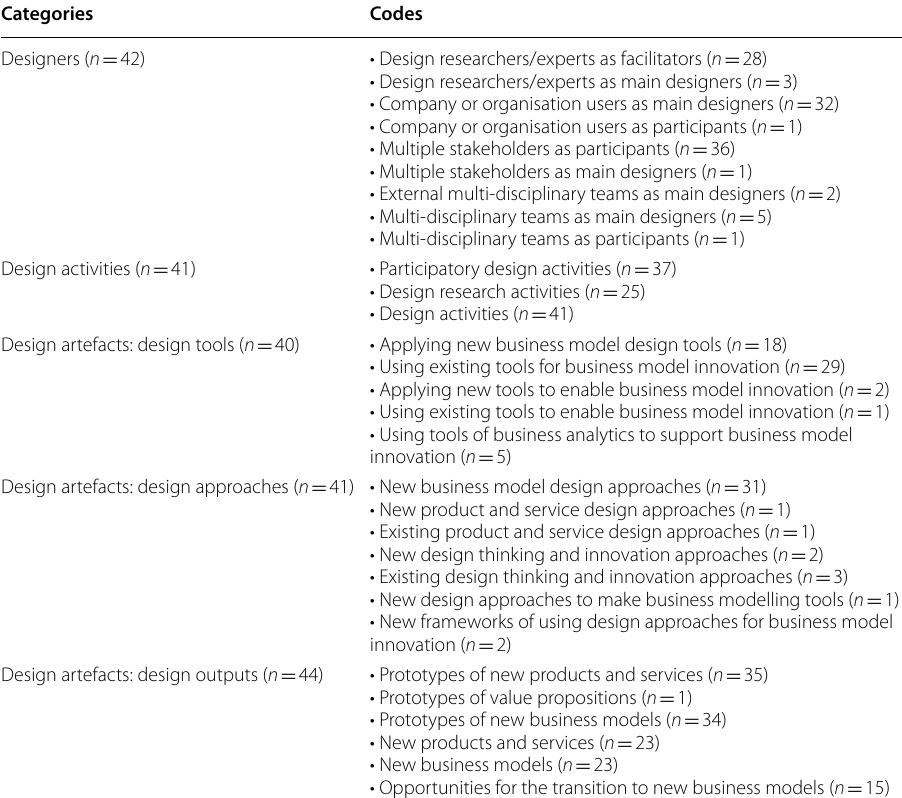
Table 6 Coding results on applying design thinking for business model innovation